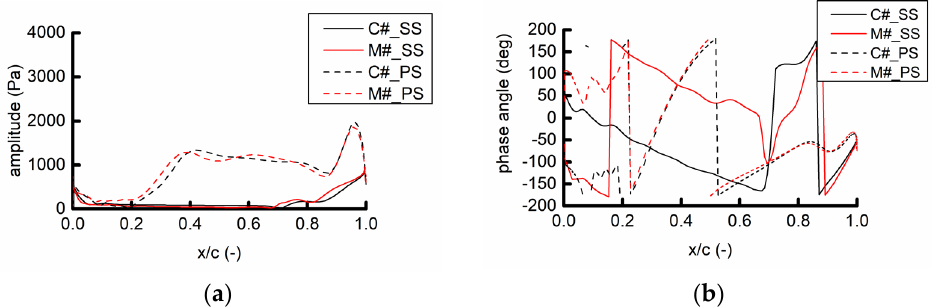
Figure 28. The 45 EO component of static pressure at 80% blade span of the R1 rotor blade. ( a ) Amplitude ( b ) Phase angle.